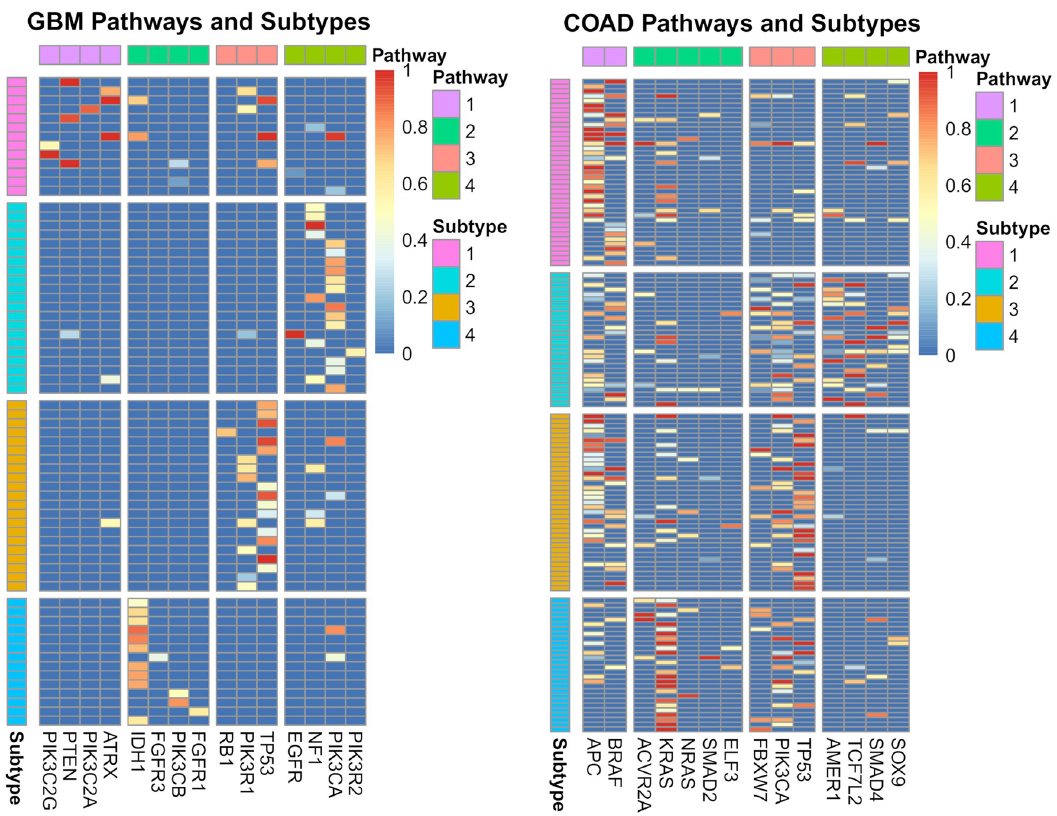
Fig 5. Heatmap showing CCF values for GBM (left) and COAD (right) datasets partitioned into pathways and subtypes.